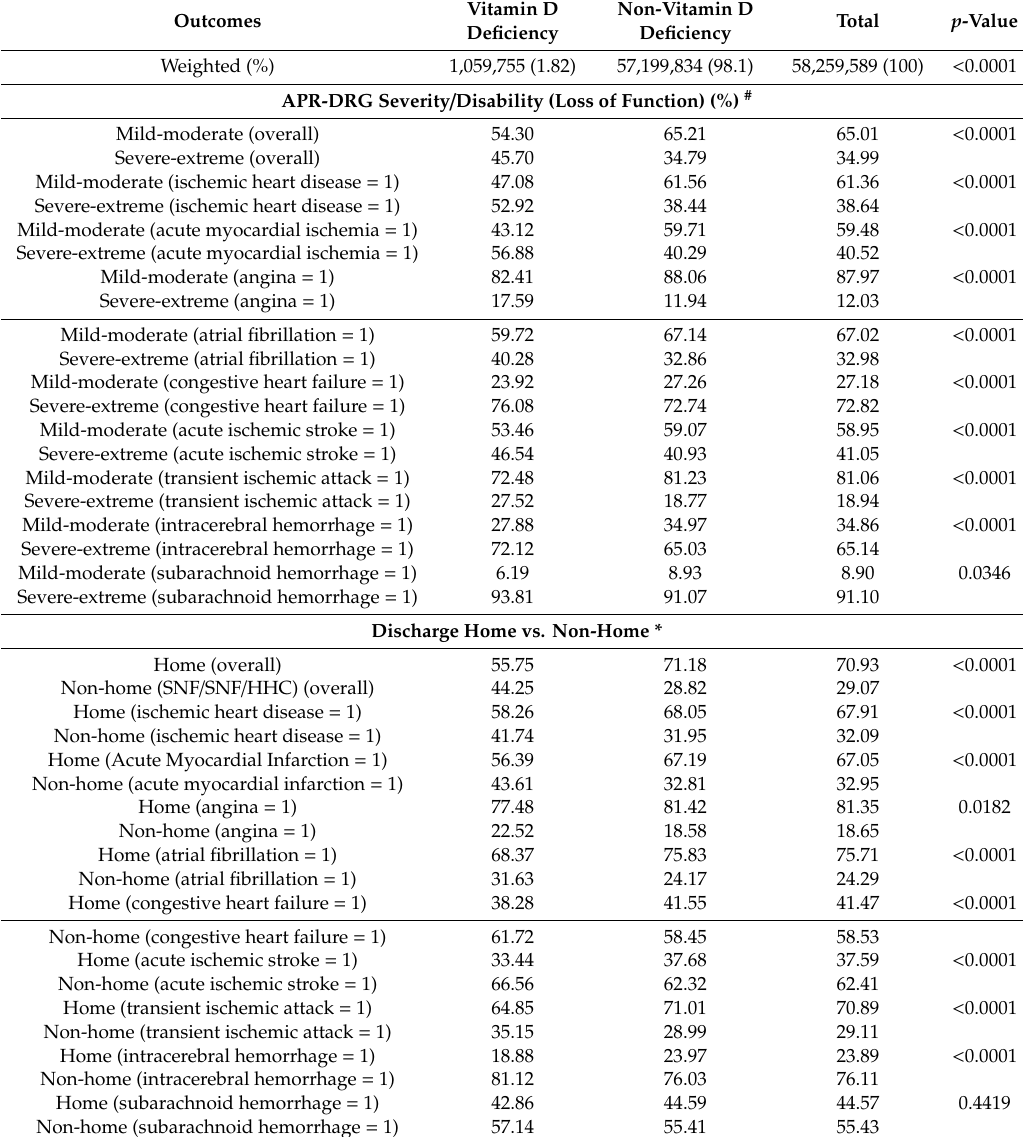
Table 3. Univariable outcomes of cardiovascular diseases and cerebrovascular disorders in the presence of vitamin D